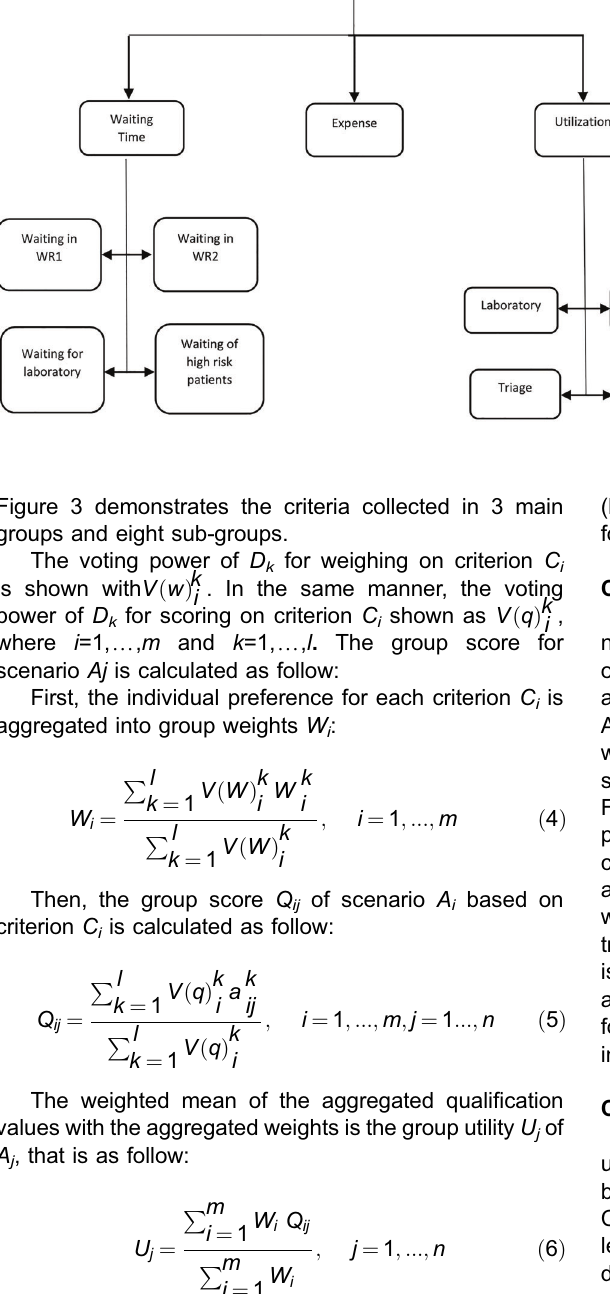
Figure 3. Criteria to use group decision making to improve performance of emergency depart- ment (ED). WR1: waiting room 1; WR2: waiting room 2; ER: emergency